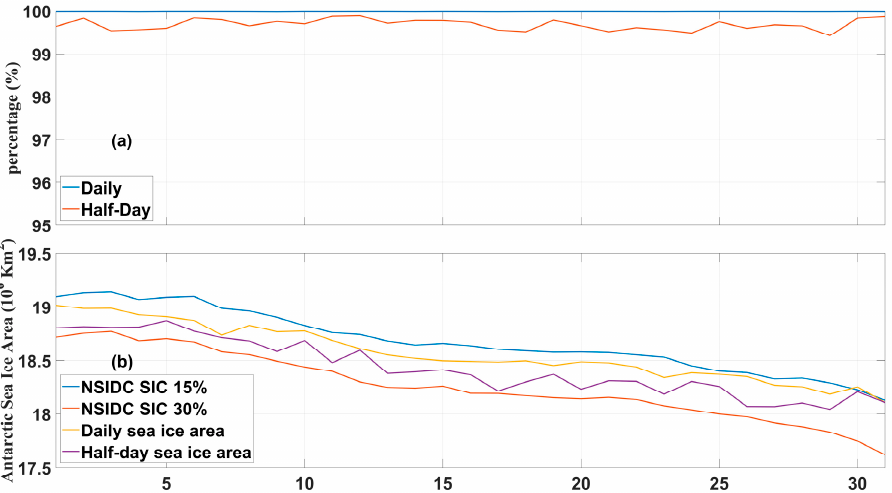
Figure 13. Comparison of acquisition of data at daily and half-day time intervals in the Antarctic for October 2020: ( a ) data coverage; ( b ) sea ice area.